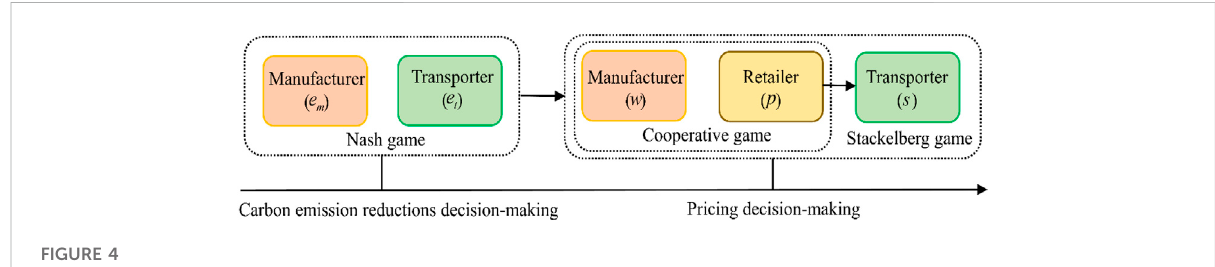
FIGURE 4 The order of decision-making and the game types of supply chain members for the NC